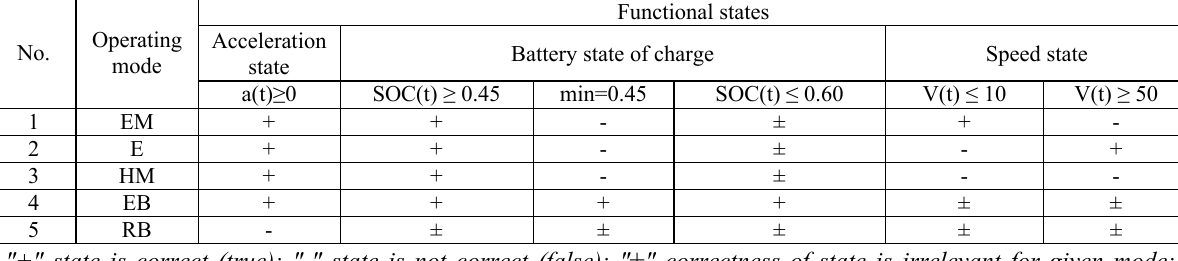
Table 3. Possible states with corresponding operating modes